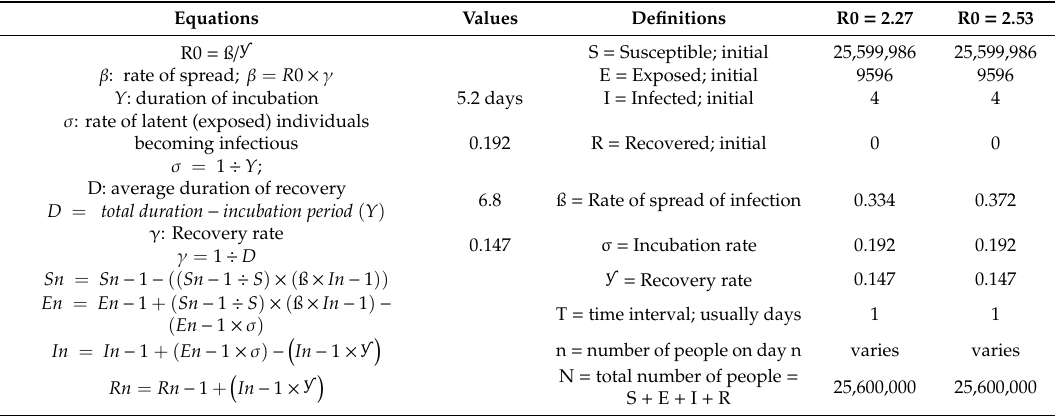
Table 3. SEIR parameters required to predict the COVID-19 pandemic for Australia. Inputting these variables into the equations will give us the parameters needed to make our predictions using the SEIR model.